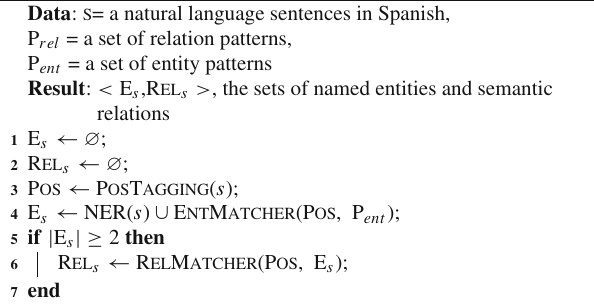
Algorithm1: GetER( s ,P ent ,P rel ) -Extractionofentities and semantic